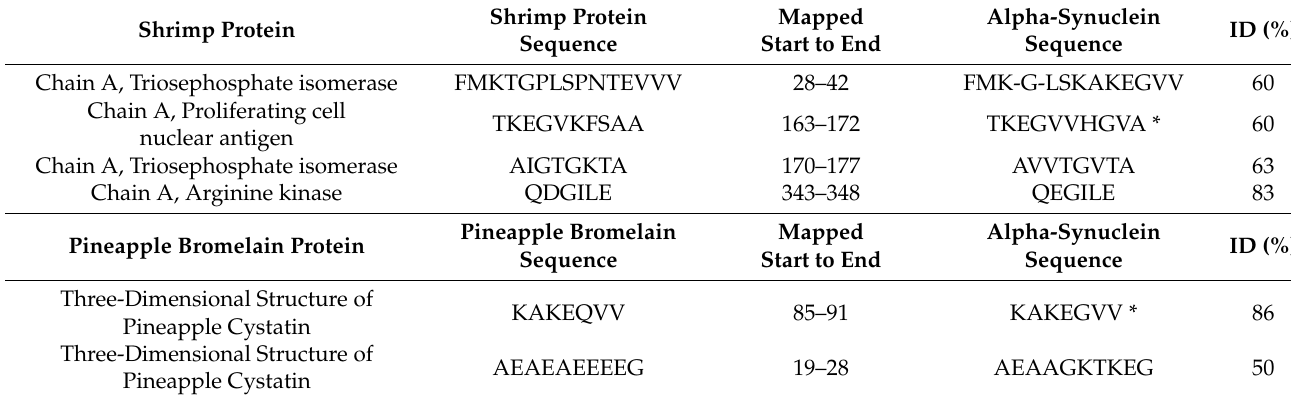
Table 8. Potential cross-reactive epitopes between alpha-synuclein proteins, and shrimp and pineapple bromelain proteins. Shrimp